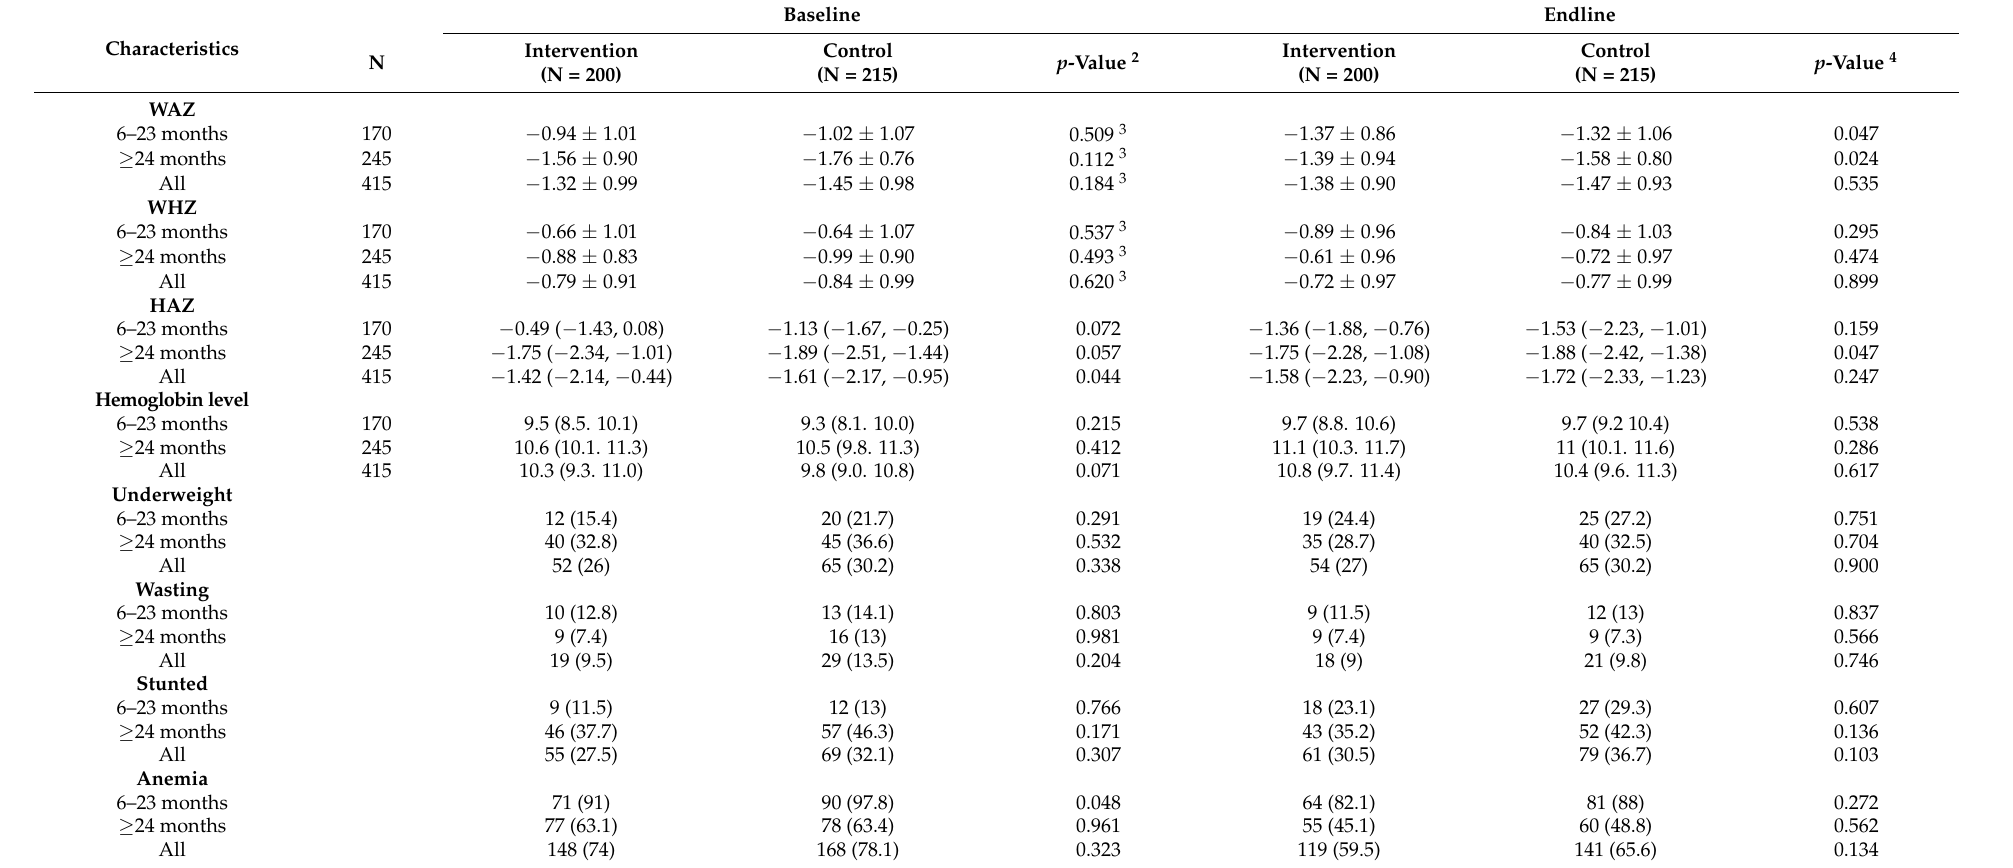
Table 4. Nutritional status at baseline and end line, by age and treatment groups 1